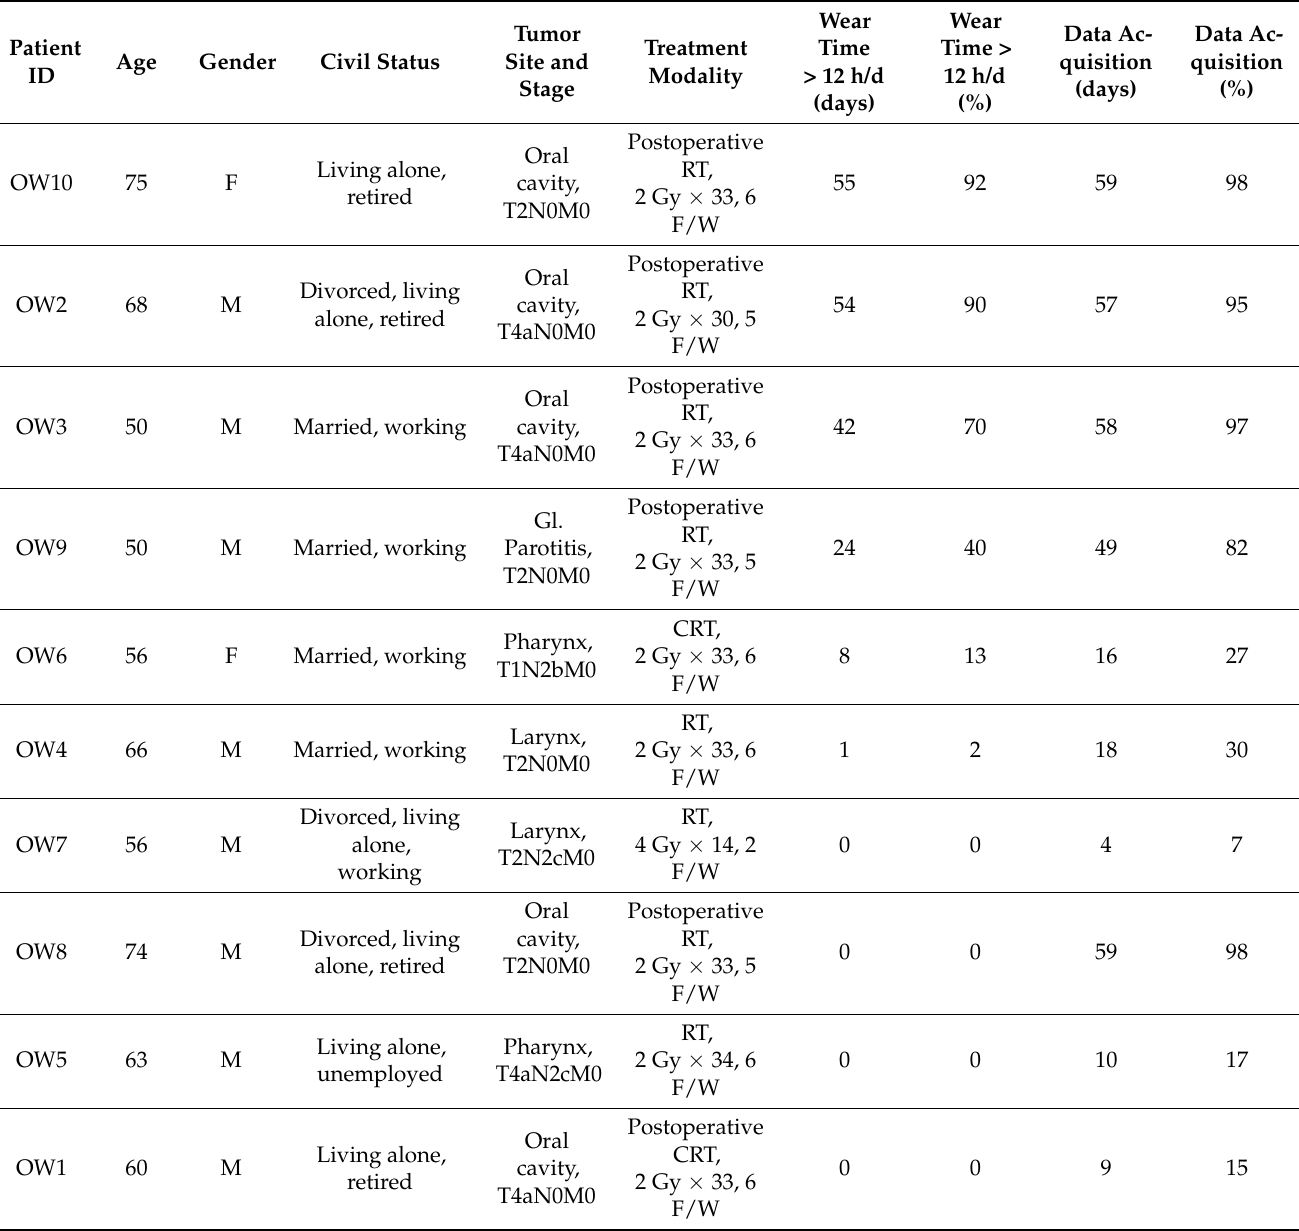
Table 2. Wear times and data